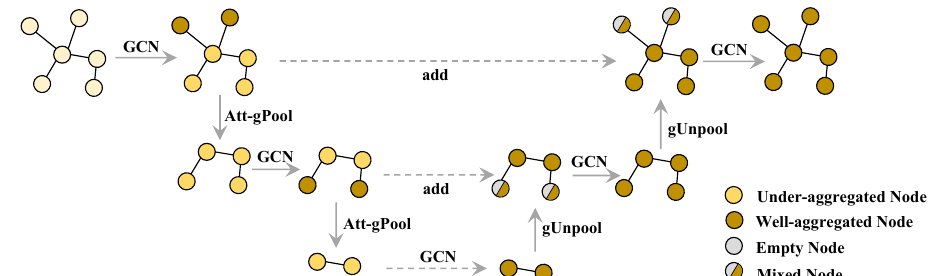
Figure 1. Overview of Graph U-Net with two attention-based graph pooling layers. In this example, the GCN layers aggregate adjacent node features and convert them into a high-dimensional repre- sentation. The Att-gPools choose nodes with high attention scores through top-k selection and send them to the next GCN for further aggregation. The gUnpools reconstruct the original graph structure by using position information and empty feature vectors of unselected nodes.